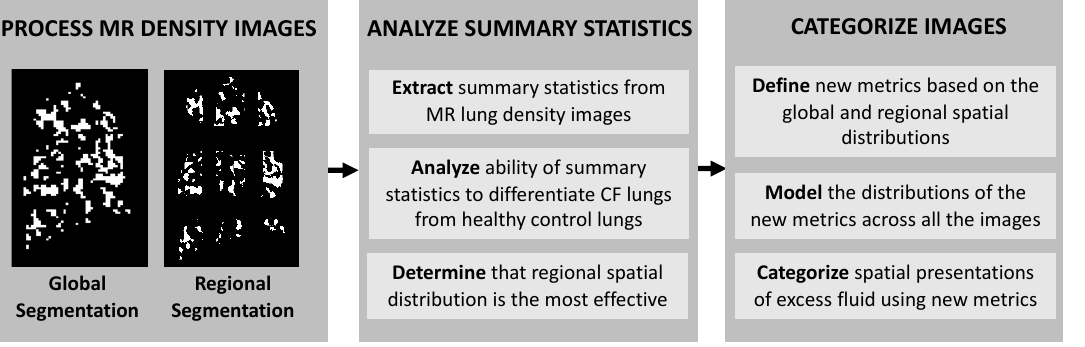
Figure 4. An overview of the study design for determining the spatial presentation of excess lung fluid.